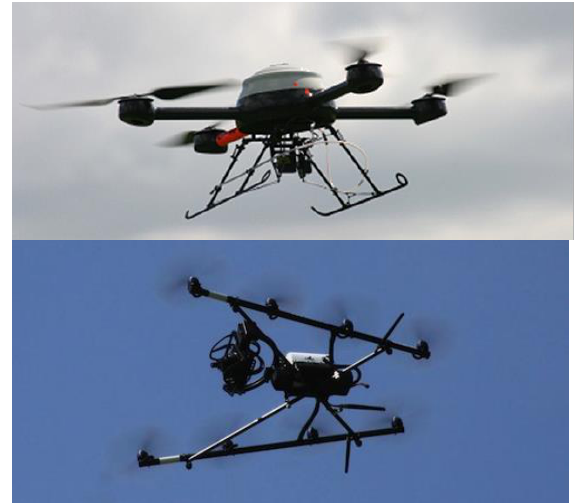
Figure 7: The Microdone MD-4 1000 (up) and AscTec Falcon 8 (down)